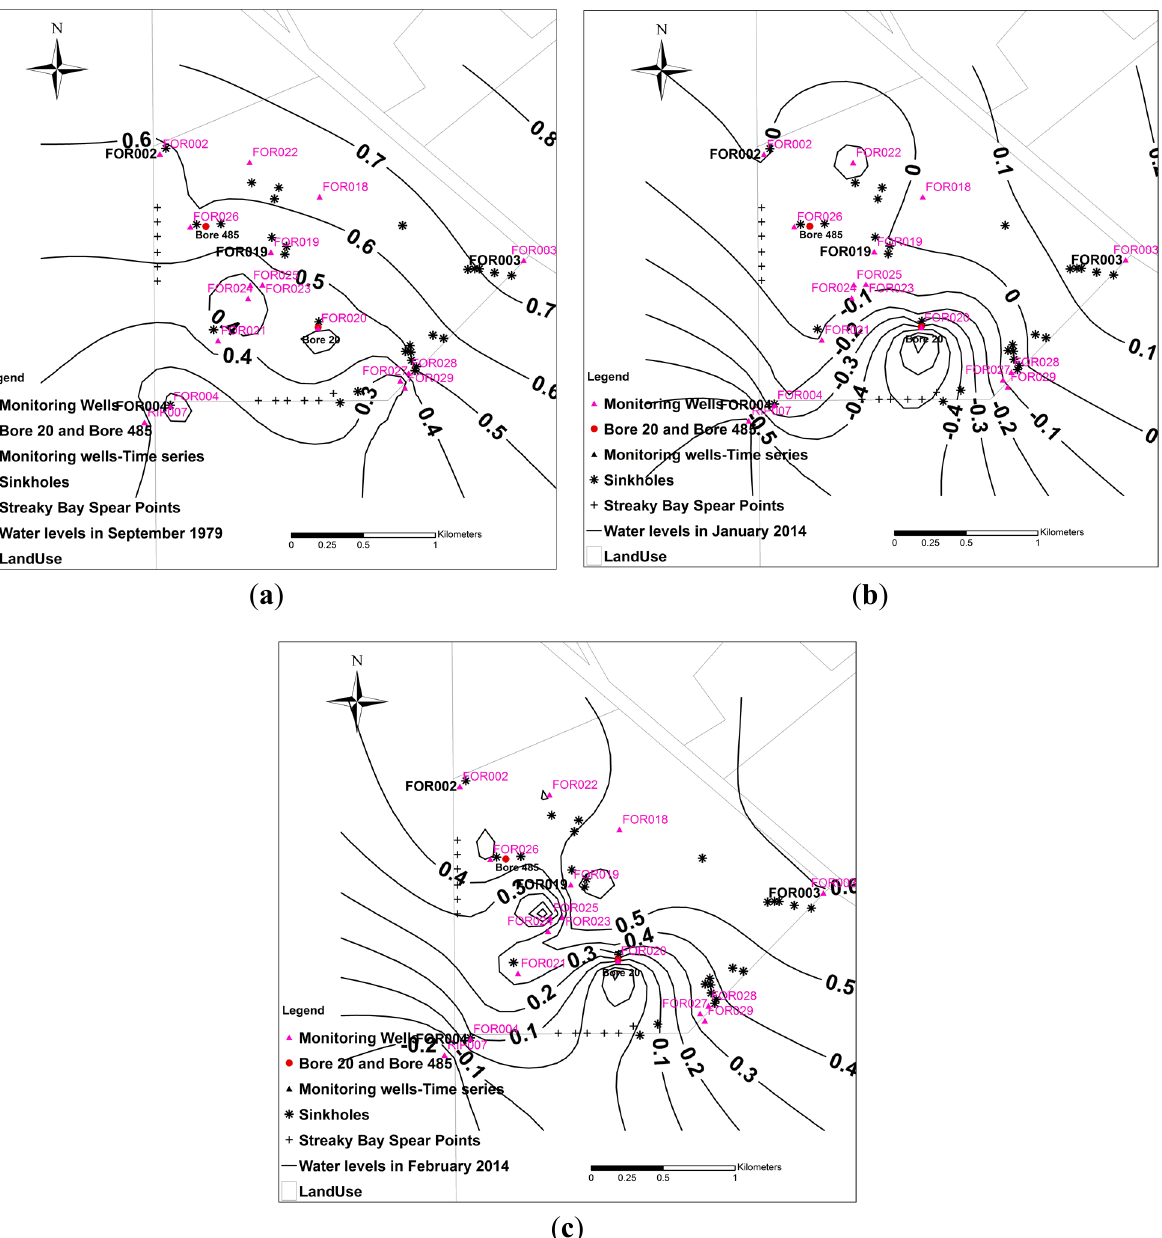
Figure 10. Water levels in Robinson lens ( a ) September 1979 ( b ) January 2014 ( c ) 28 February